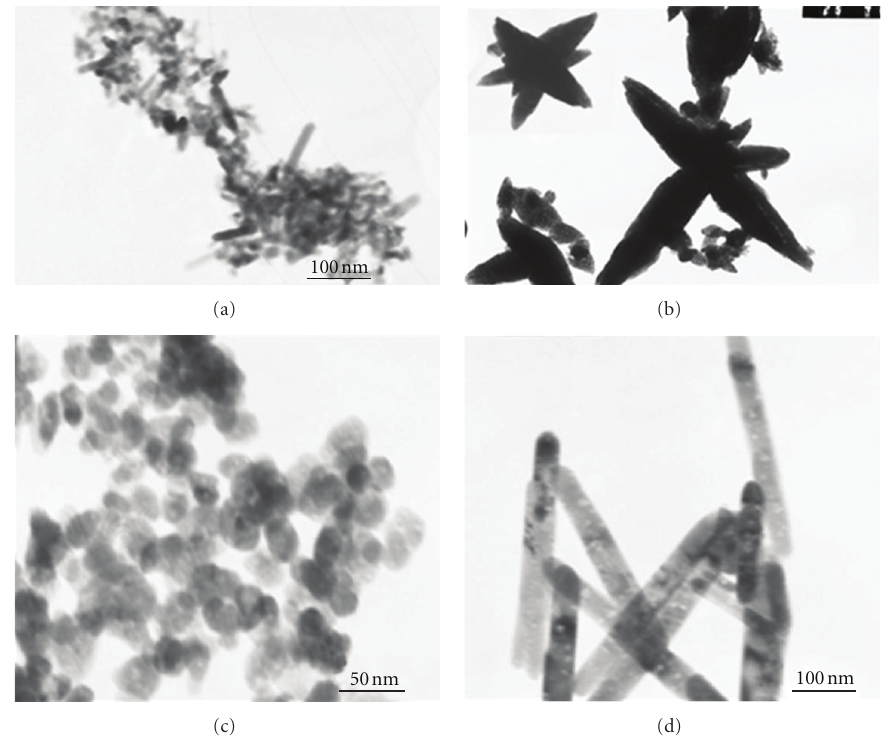
Figure 2: TEM images of ZnO nanoparticles synthesised in various solvents, ethanol (a), acetone (b, c), and water (d) at 120 ◦ C and time of 15 minutes under